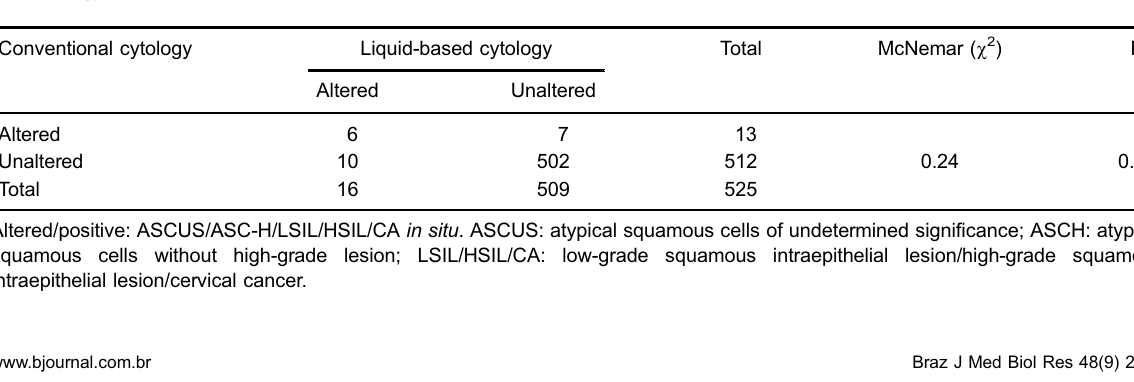
Table 4. Comparison of altered result rates of 525 patients who underwent conventional cytology and liquid-based ThinPrep methodology in the State of Pernambuco, 2011. Conventional cytology